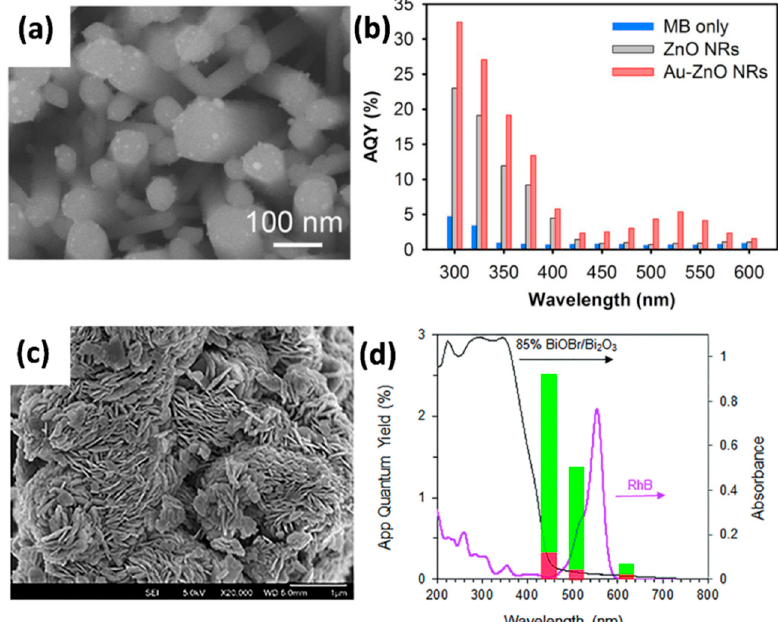
Figure 4. ( a ) SEM image of Au–ZnO and ( b ) AQY of MB photodegradation on MB only, ZnO NRs, and Au–ZnO NRs in the wavelength range from 300–600 nm (reproduced with permission from [44]. Copyright Nature Publishing Group, 2016). ( c ) SEM image of BiOBr / Bi 2 O 3 composites and ( d ) the corresponding AQY of RhB (red) and p -cresol (green) photodegradation under blue, green, and red light-emitting diode (LED) light irradiation (reproduced with permission from [45]. Copyright Royal Society of Chemistry, 2017.).